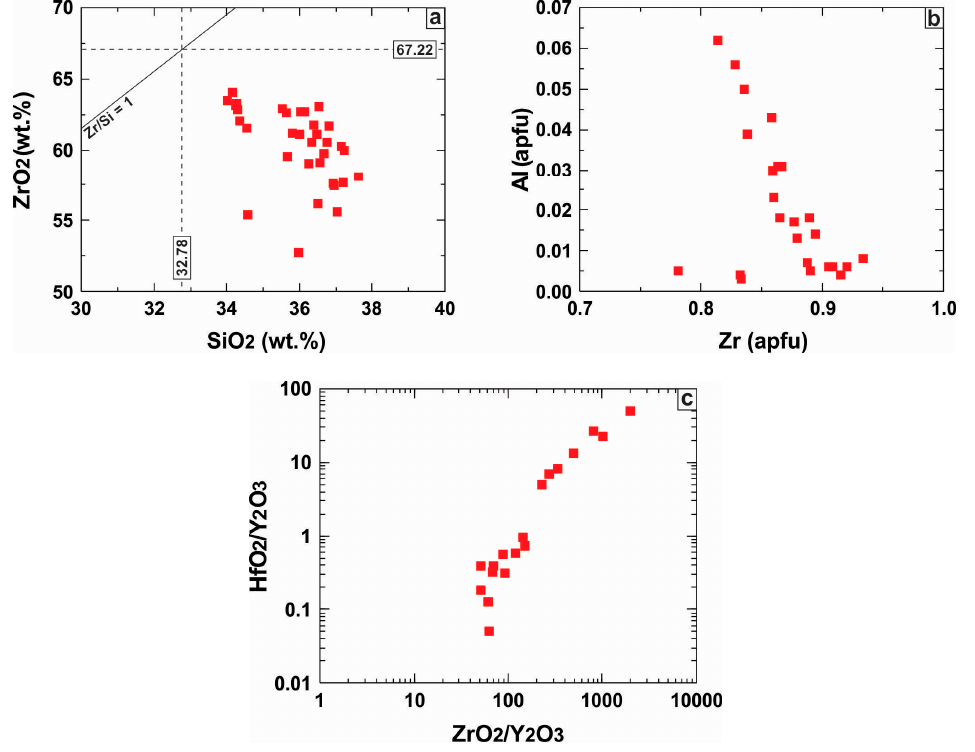
Figure 13. Plot of major and minor element abundances in zircon in the following variation diagrams: ( a ) ZrO 2 vs. SiO 2 ; ( b ) Al vs. Zr at. %; ( c ) HfO 2 /Y 2 O 3 vs. ZrO 2 /Y 2 O 3 .